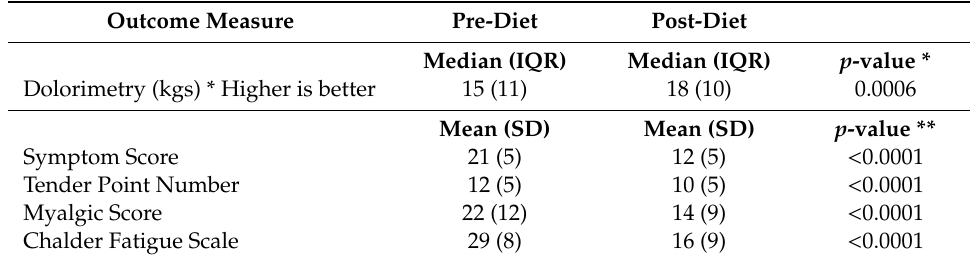
Table 4. Change in outcome measures pre–post diet for all subjects.